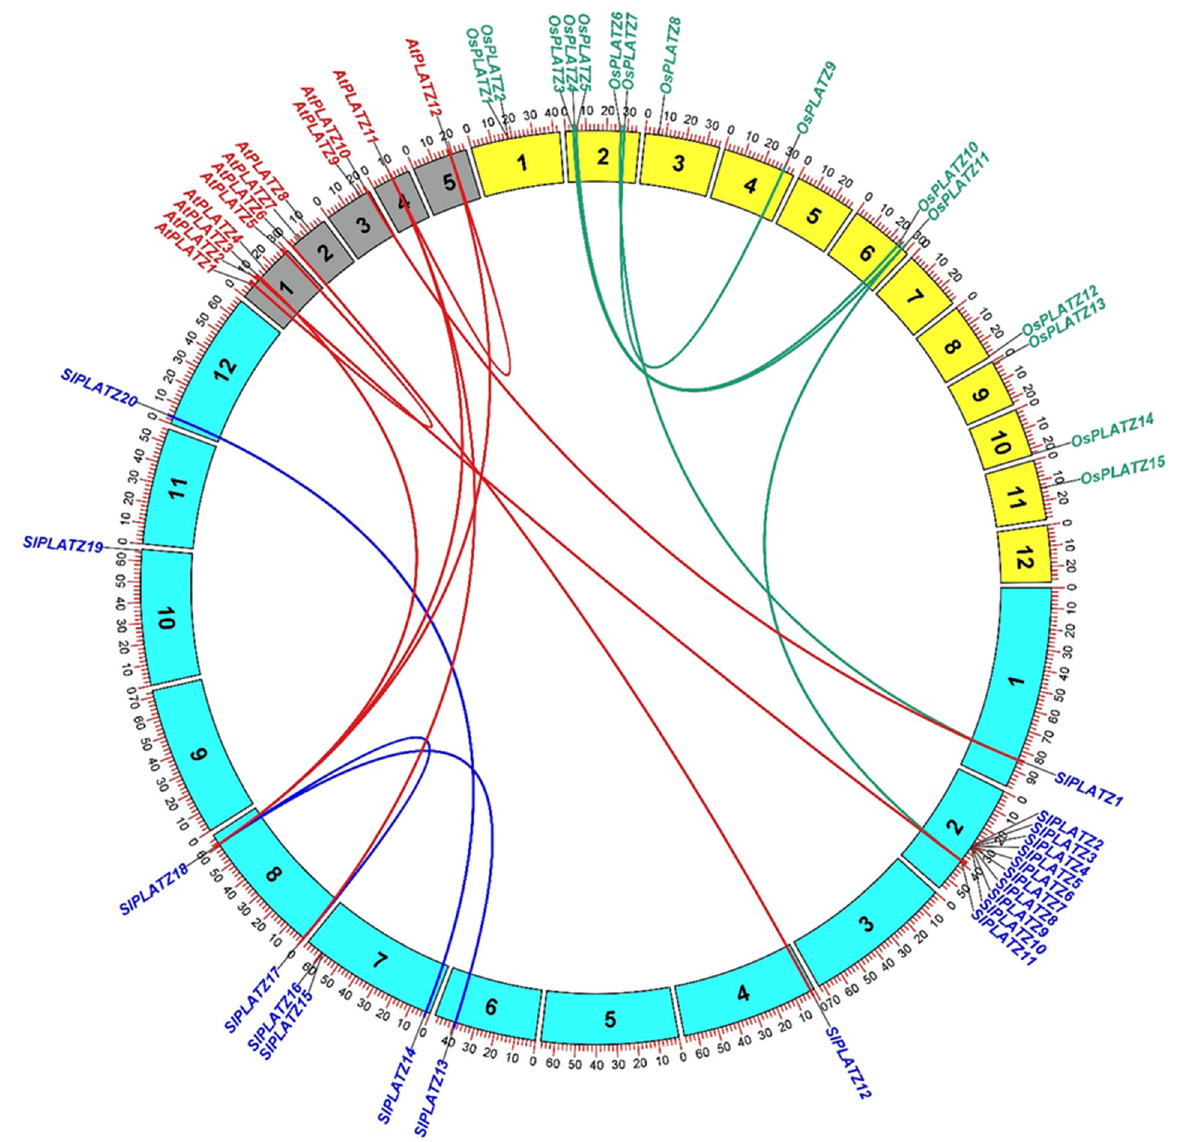
Figure 4. Schematic diagram depicting the microsyntenic relationship of PLATZ genes across Ara- bidopsis, tomato, and rice. The chromosomes from three plant species are illustrated with the scale in megabase pairs (Mbp) and marked in gray for Arabidopsis, yellow for rice, and aqua for tomato, respectively. Blue lines link the segmentally duplicated genes in tomato.